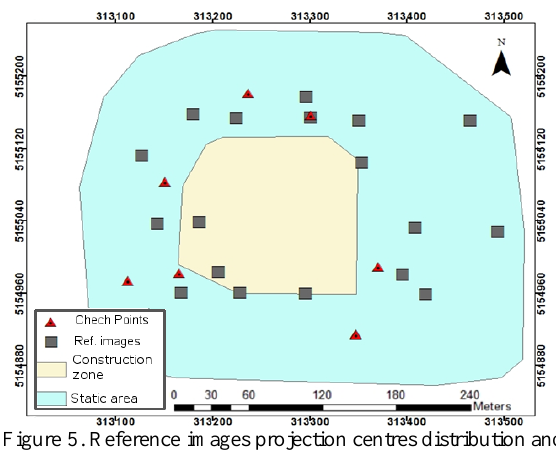
Figure 5. Reference images projection centres distribution and